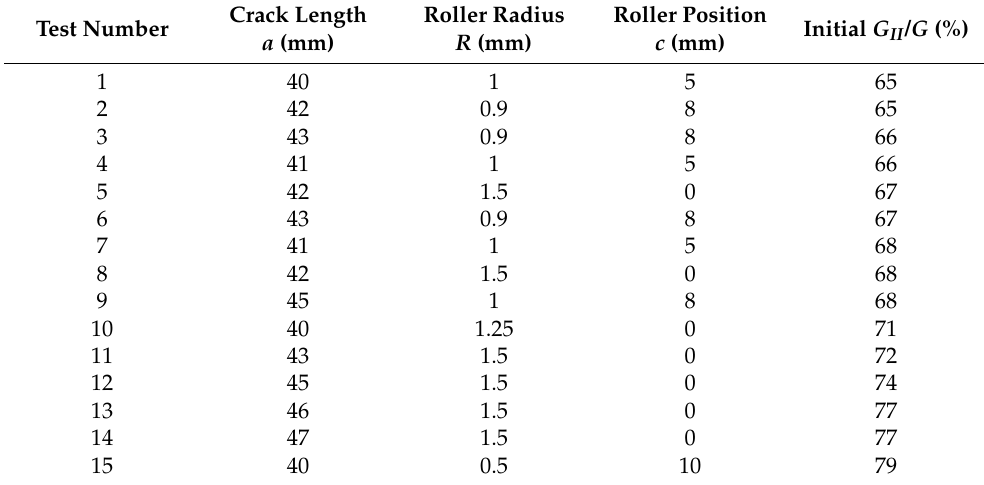
Table 1. Summary of the test parameters for the fifteen